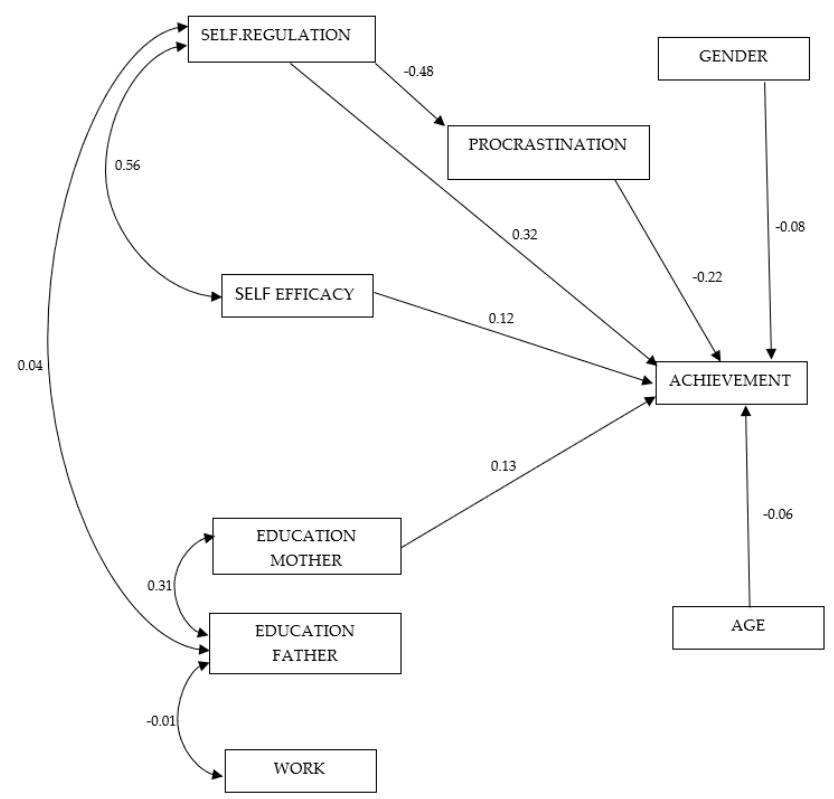
Figure 1. Obtained structural model prediction.